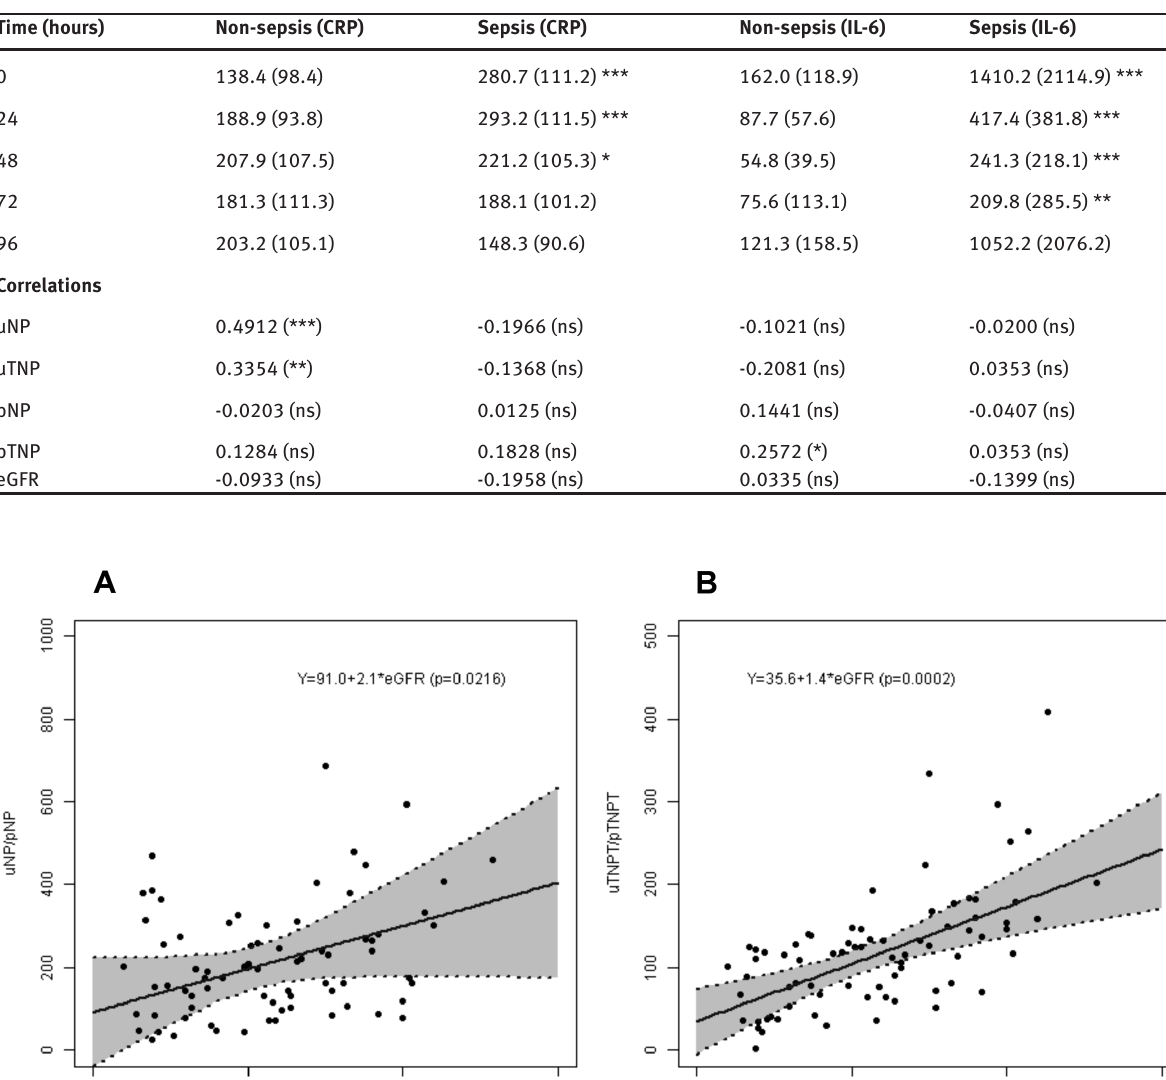
Table 4: Plasma IL-6 and CRP values are correlated against urinary and plasma neopterin and total neopterin values. Daily CRP and IL-6 values are shown for non-sepsis and sepsis groups with standard deviation. Significance values are compared between non-sepsis and sepsis values for the corresponding biomarker. Plasma CRP values are measured as mg/L and plasma IL-6 is measured as ng/mL. Correlations were determined using individual data and are displayed as r values with significances. *<0.05, **p<0.01, ***p<0.001, ns = not